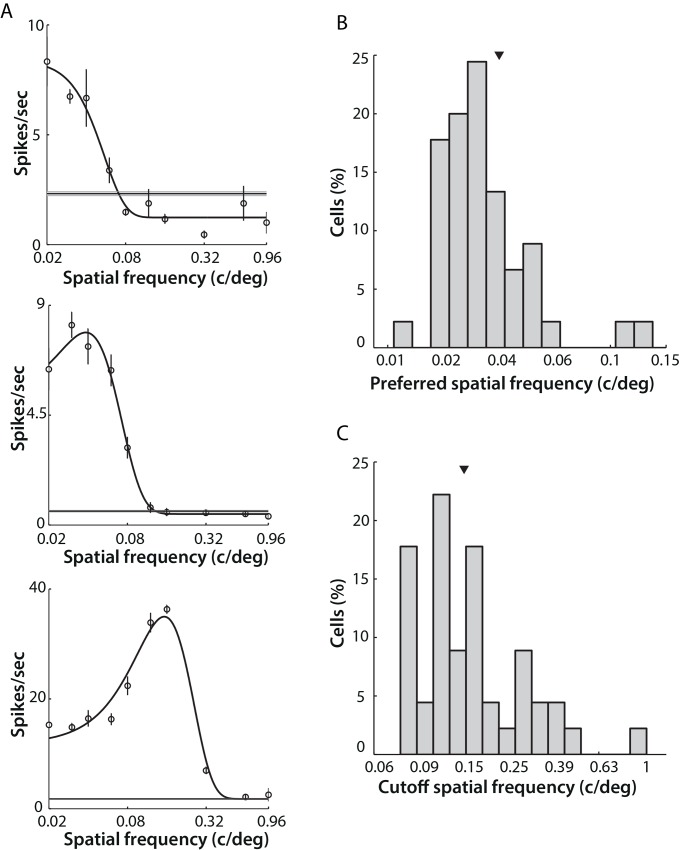
Spatial frequency tuning properties of mouse LGN cells.A) Examples of spatial frequency tuning of three single cells. Open circles indicate mean firing rates and error bars indicate SEM across six repeated presentations of the drifting gratings. Black curves show the best fits of these raw data to a DoG function. The grey area indicates the SEM of spontaneous activity, with thinner lines indicating mean values. Note: logarithmic scale of x-axis. Top left, a typical cell showing a “low-pass” tuning response. Middle panel: a “band-pass” cell. Bottom left, a “bandpass” cell preferring higher spatial frequencies. B) Distribution of preferred spatial frequency for bandpass cells (45 cells of 92). Median (arrow) = 0.035 c/deg. C) Distribution of cut-off spatial frequency for bandpass cells. Median (arrow) = 0.16 c/deg.